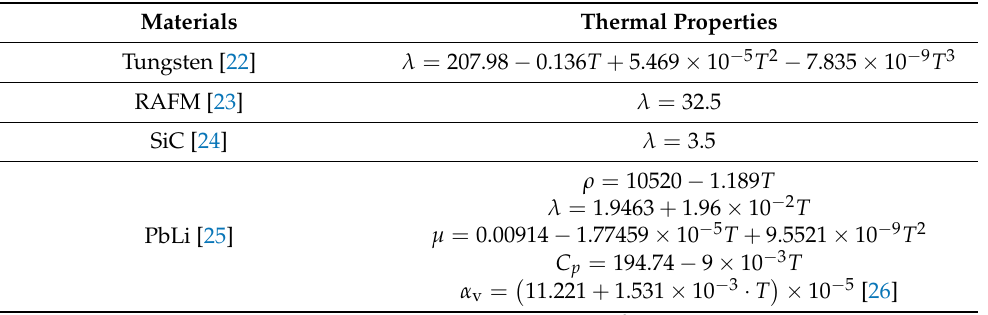
Table 3. Thermal properties of materials.